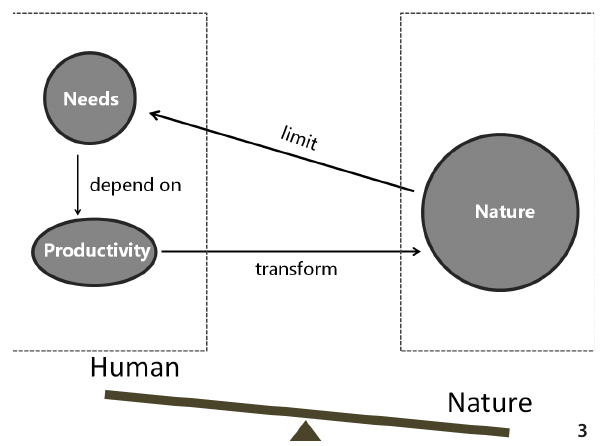
Figure 3 The human-nature conflict of ‘weak human and strong nature’ (Source: authors)